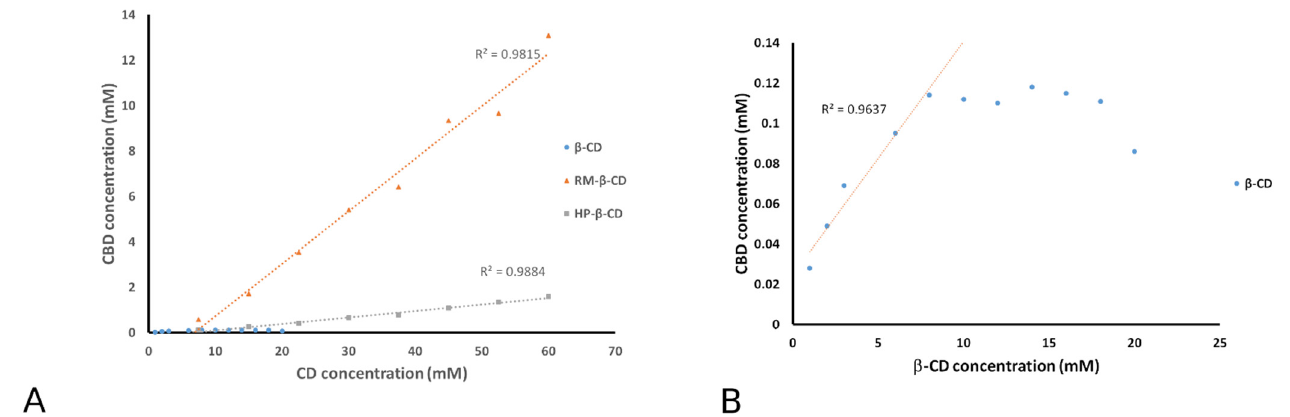
Figure 2. ( A ) Phase solubility diagrams of CBD/ β -CD, CBD/RM- β -CD, and CBD/HP- β -CD systems in water at 25 °C ( n = 3) and ( B ) the linear portion of the CBD/ β -CD diagram. Table 2. Stability constants (K 1:1 ) and Complexation Efficiency (CE) calculations of CBD inclusion complexes with the native and two modified β -CDs at 25°C ( n = 3).